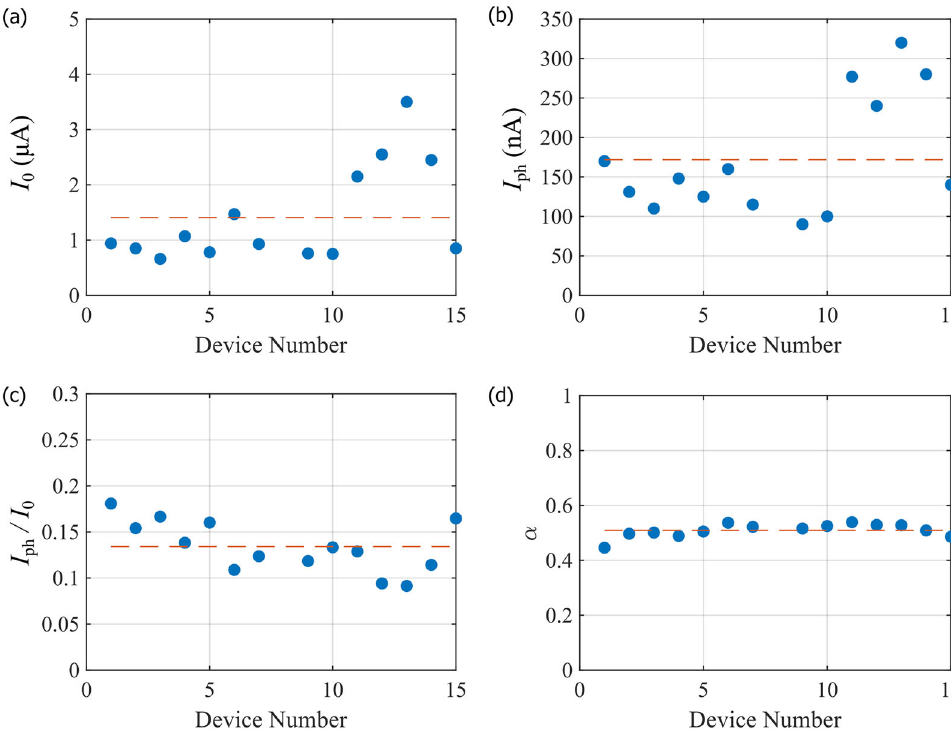
Fig. 7 Reproducibility of the devices. “ Dark ” current I 0 ( a ) and photocurrent I PC ( b ) registered in 15 different devices. c Ratio between I PC and I 0 . d α coef fi cient extracted from fi tting the power dependence of I PC to I PC ∝ P α . The orange, dashed lines in panels a – d represent average values over the full set of 15